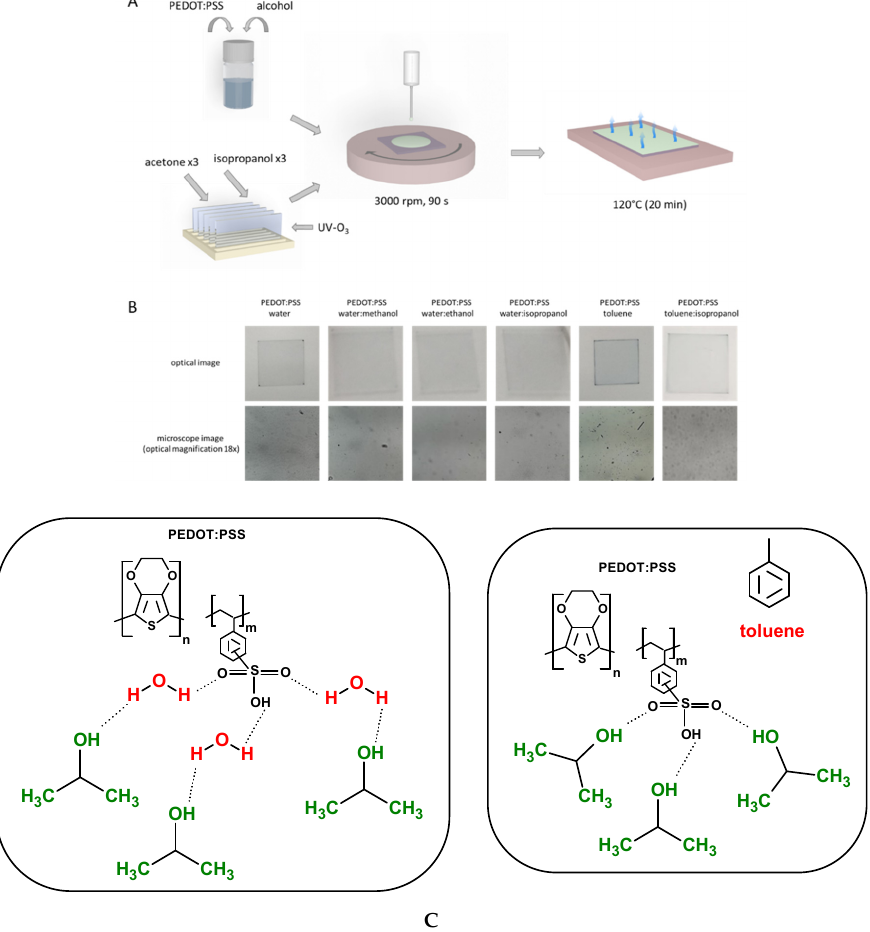
Figure 2. Scheme of layer preparation using spin coating technique ( A ); images of PEDOT:PSS layers (spin coated at 3000 rpm, 90 s) and microscopic images acquired at optical magnification of 18× ( B ); scheme of primary and secondary hydrogen bond interactions of PEDOT:PSS in water and toluene with isopropanol ( C ).